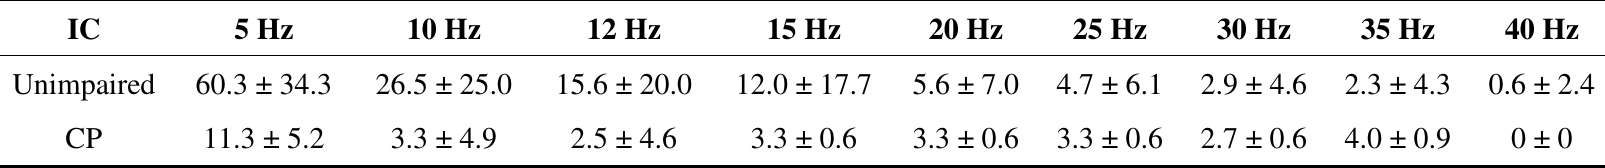
Table 1. Absolute mean difference ± one standard deviation (ms) in detection of Initial Contact (IC) using raw data and data low pass filtered from an unimpaired subject and one subject with CP. The cut off frequencies used were 5, 10, 12, 15, 20, 25, 30, 35 and 40 Hz. n = 34 IC events for unimpaired subject and 15 for subject with CP.